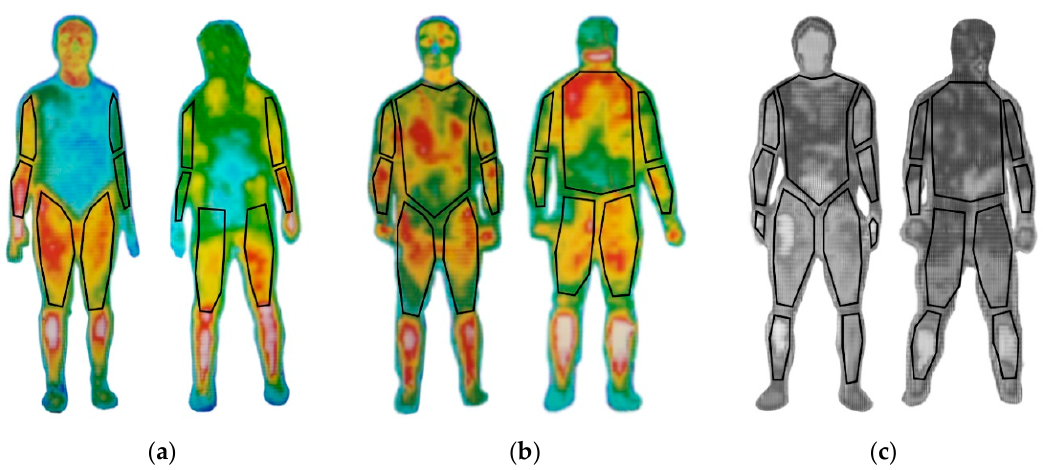
Figure 1. Definition of the regions of interest (ROIs; front and back side) used to calculate the mean temperature on the body for foil fencers ( a ) and epee fencers ( b ). Definition of the ROIs for the single body parts ( c ). Note that, to evaluate the temperatures, only the parts covered by the fencing uniform were considered. Since foil fencers wear an additional electric jacket over the uniform, the trunk was not considered in the definition of the ROIs for these athletes. Athletes were asked to remove the protective glove before acquiring the thermal image.